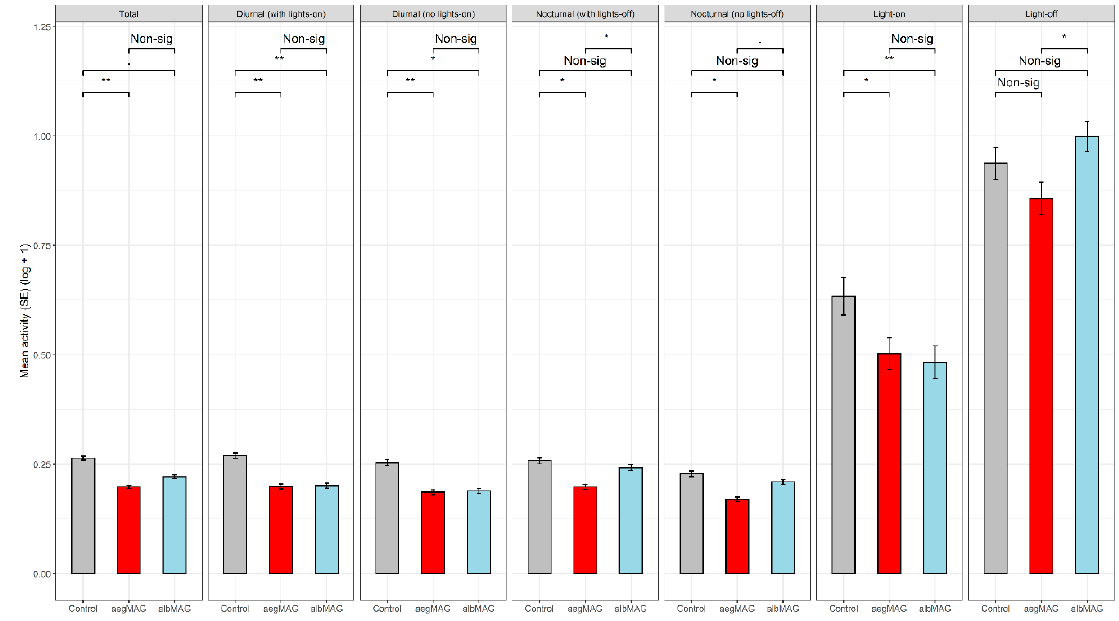
Figure 3. Total activity, diurnal activity, diurnal activity without lights-on, nocturnal activity, nocturnal activity without lights-off, lights-on activity and lights-off activity of Ae. albopictus females injected with saline (Control; n = 63), accessory gland of Ae. aegypti males (aegMAG; n = 70) and accessory gland of Ae. albopictus males (albMAG; n = 74). * = significant at alpha = 0.05; ** significant at alpha = 0.001; Non-sig = Non-significant at alpha = 0.05.